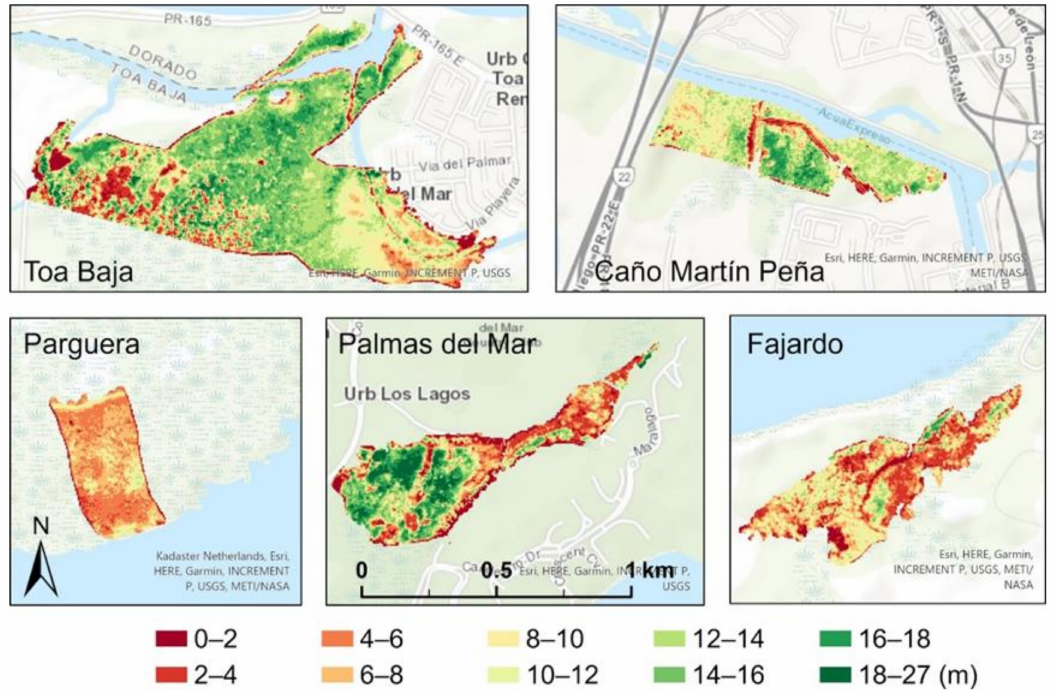
Figure 3. The pre-hurricane canopy height, derived from the G-LiHT point-cloud data. The forests in Palma del Mar and Fajardo are the closest to rivers/canals with mean distance of 57.8 ± 55.3 and 83.8 ± 60.8 m (Table 2), respectively, whereas the forest in La Parguera does not have any rivers or canals nearby and the nearest rivers/canals are 948.1 ± 157.9 m away. The forest near Caño Mart í n Peña has the closest mean distance to coastal water (101.2 m) because we treated the water in the Channel of Mart í n Peña as salty. The Pterocarpus forest in Palma del Mar grows inward to the land and is connected to the coast by channels and a river, such that the forest has the farthest mean distance to the coast (710.3 m). The great mean distance of 516.9 m to the coast and the medium distance of 341.5 m to the river/canals of the Toa Baja Forest are largely because of its large area of 71.1 ha. Windspeed and rainfall interpolated from the ground observations during the hur- ricane [31,40] showed that the mean gust windspeed was the highest at Palma del Mar (49.5 m · s − 1 , Table 2), the site closest to the landfall of Hurricane Maria, whereas La Parguera in the southwest farthest from the hurricane path had the lowest mean gust windspeed (34.1 m · s − 1 ). The other three sites in between also had gust speeds of more than 44 m · s − 1 . The hurricane-brought rainfall showed more variation across sites than gust